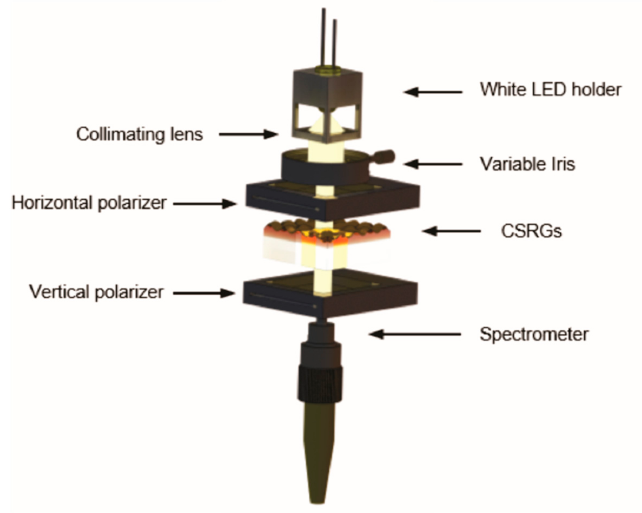
Figure 2. Schematic of the optical platform for transmission-based spectroscopy using CSRGs. All the elements are arranged in a collinear arrangement on a vertical rail. The light from the white LED passes through a variable iris, to control the spot diameter upon the horizontal polarizer, which is then incident on the CSRGs exciting the plasmons. The resulting out-coupled light then traverses the vertical polarizer, annulling all residual light from the white LED source, except the plasmonic signal detected by the spectrometer.